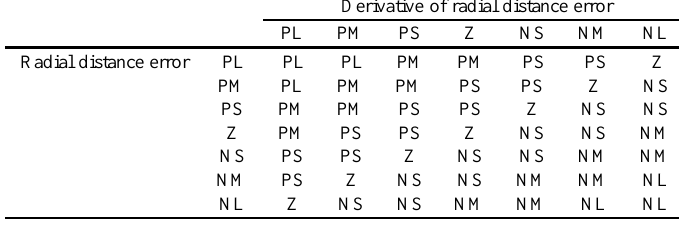
Fig. 7. Fuzzification of φ ( t )